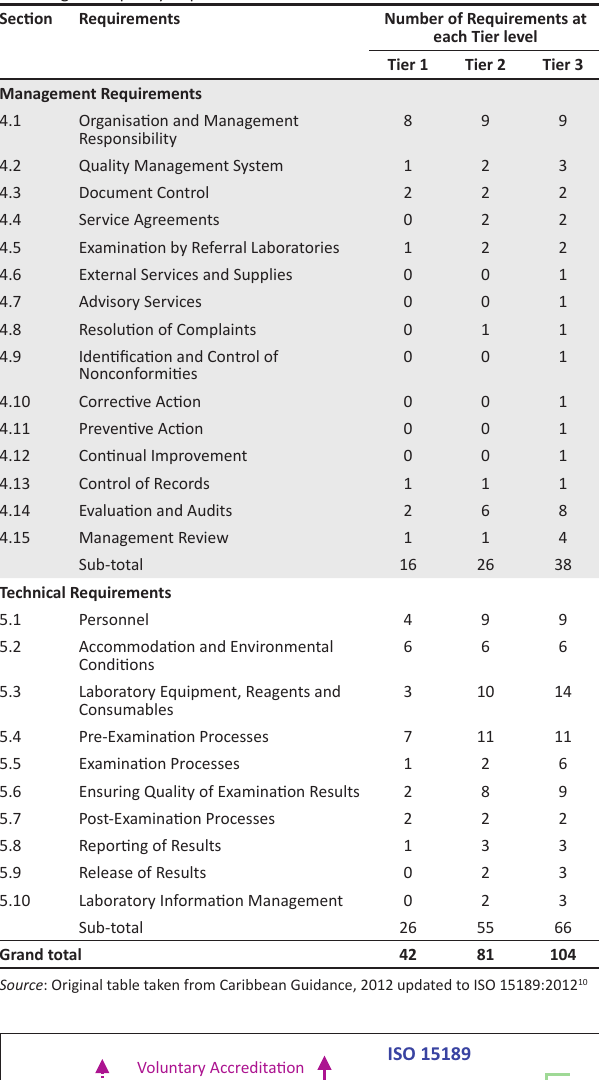
TABLE 1: Checklist of the Caribbean Laboratory Quality Management Systems Stepwise Improvement Process, showing how laboratories will be scored following their quality improvements.